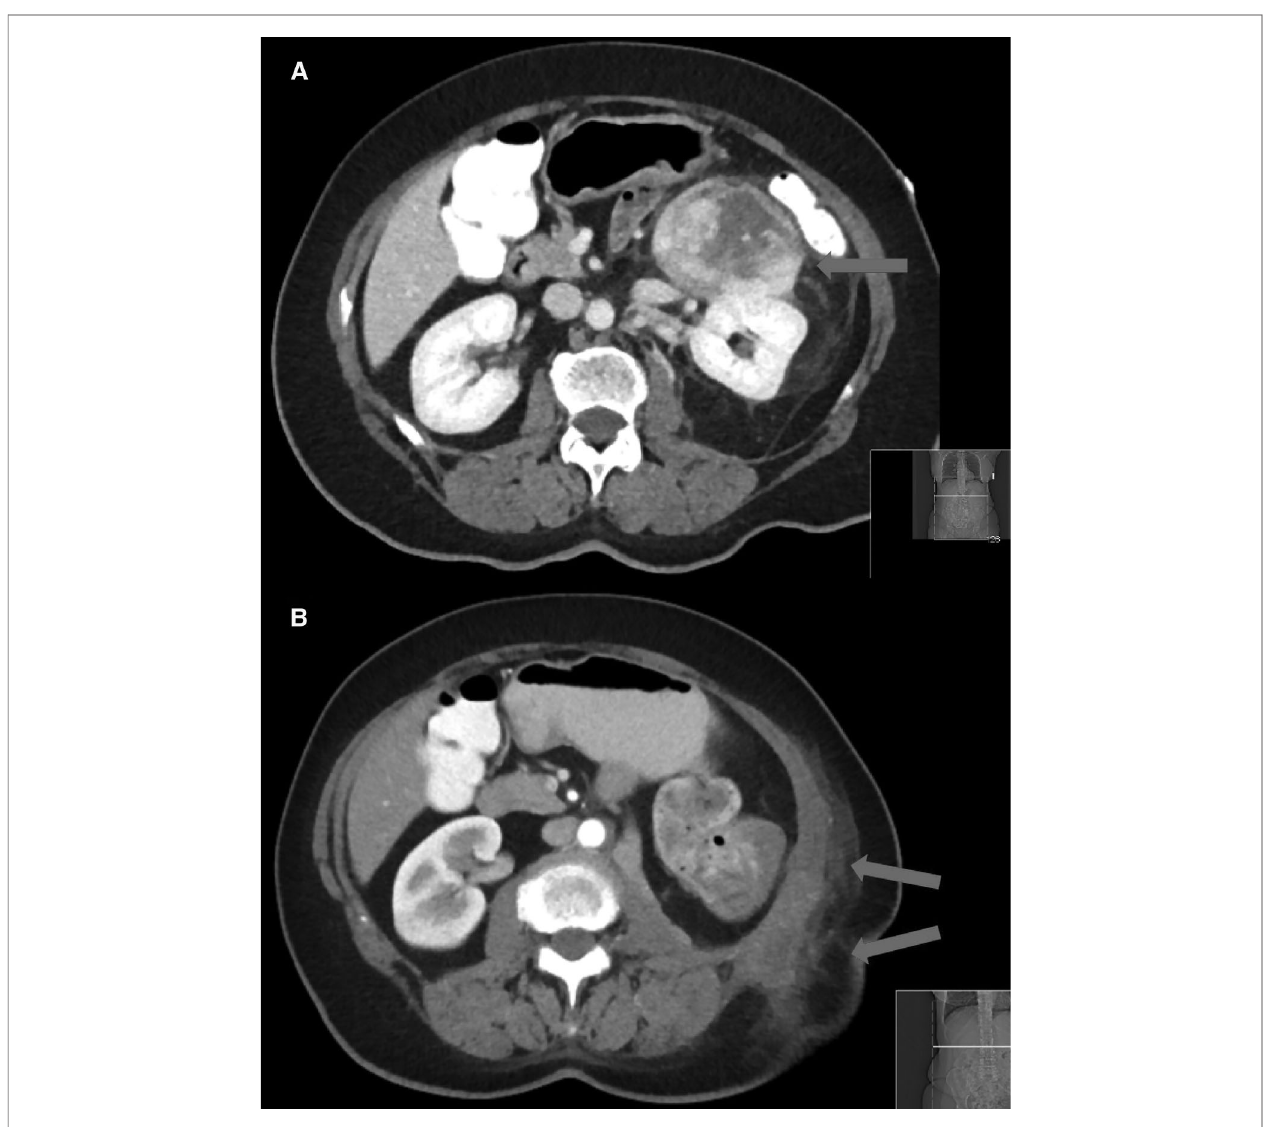
Figure 1 | Computer tomography of a retroperitoneal sarcoma ( A ) prior the resection through a fl ank incision and ( B ) the local recurrence at one month after the resection con fi rmed with a